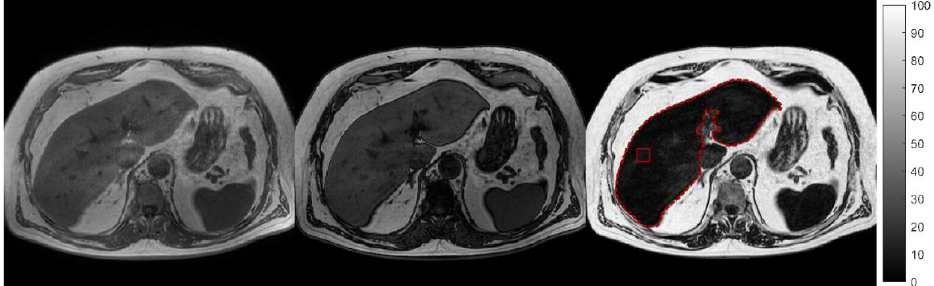
Figure 1. In-phase, opposed phase and MRI-PDFF map segmentation of the entire liver (dotted red line) with the corresponding ROI colocalized with that used for MRS (solid red line).